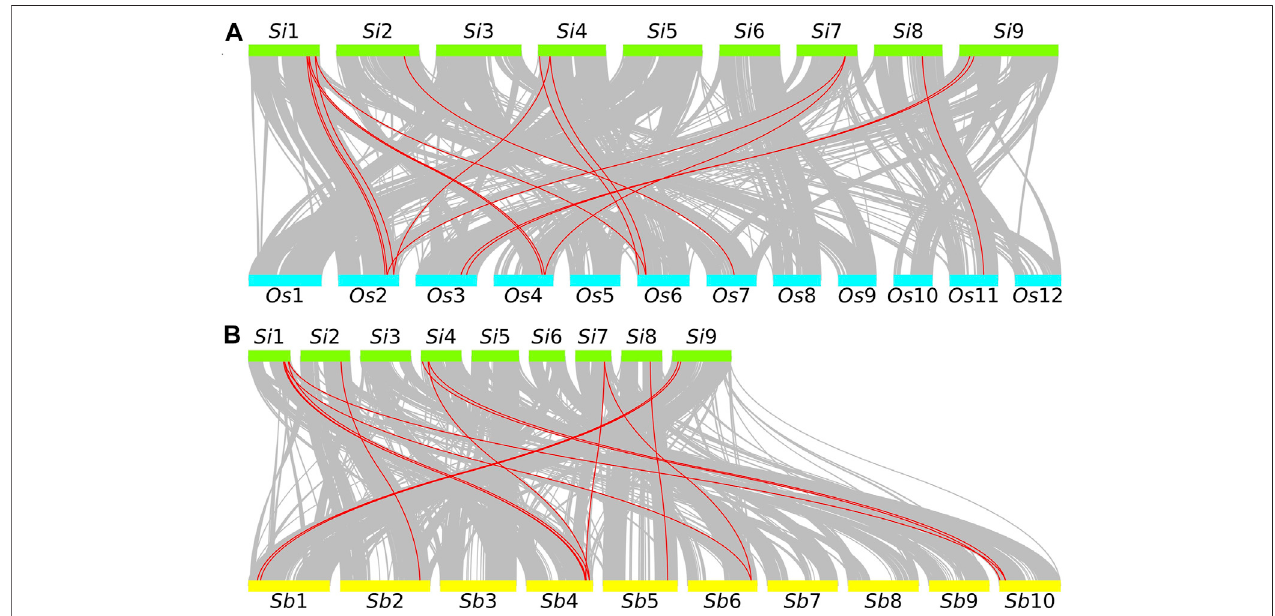
FIGURE 4 | Collinearity analysis of foxtail millet GRF and related species. (A) The green rectangular color block represents the foxtail millet chromosome. Si represents foxtail millet. The number represents the chromosome number. The blue rectangular color block represents the rice chromosome. Os represents rice. The number represents the chromosome number. (B) The green rectangular color block represents the foxtail millet chromosome. Si represents foxtail millet. The number represents the chromosome number. The yellow rectangle represents the sorghum chromosome. Sb represents sorghum. The number represents the chromosome